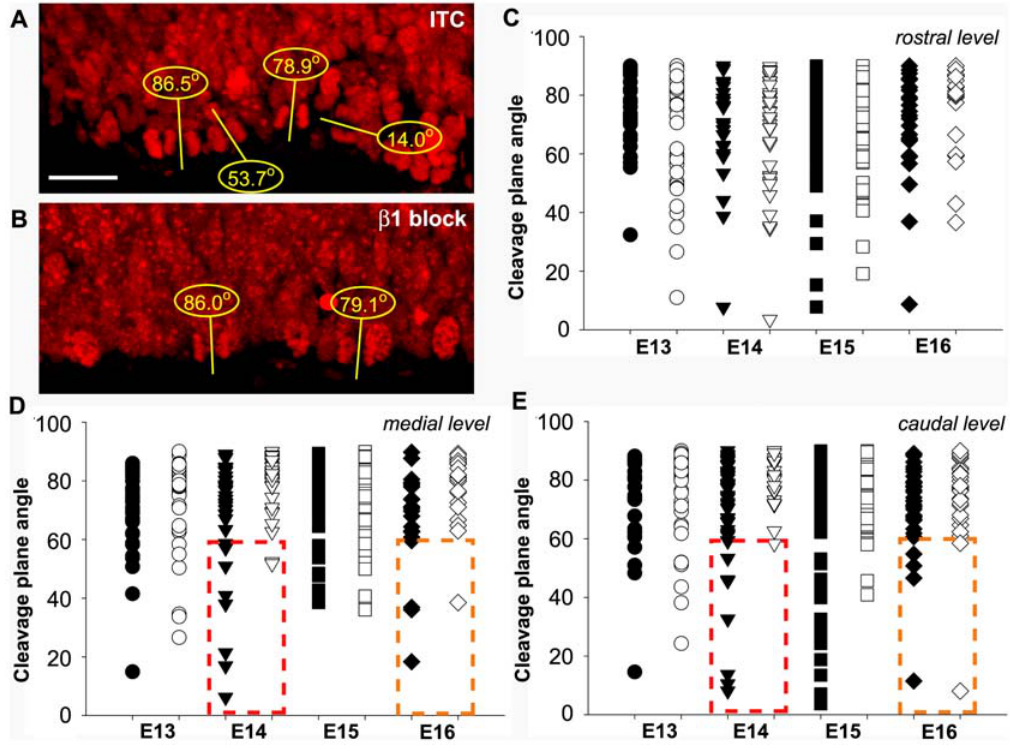
Figure 3. Intraventricular injection of b 1 integrin blocking antibody prevents VZ horizontal mitotic cleavages throughout neurogenesis. (A, B) Micrographs of cells stained with propidium iodide in E14 telencephalon 18 h post ITC (A) or b 1 integrin blocking antibody (B) injection. (C–E) Distribution of mitotic rostral (C), medial (D), and caudal (E) progenitors according to their angle of cleavage in ITC (black symbols) or b 1 integrin blocking antibody (white symbols)-injected forebrains. Boxed regions highlight the paucity of horizontal cleavages (lower than 60 degrees) in Ha2/5-injected embryos. Scale bar represents 15 m m.